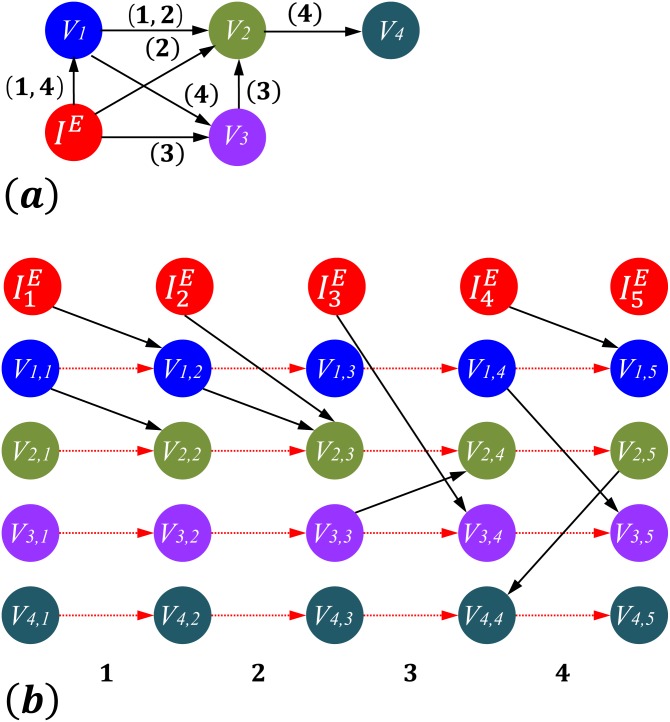
Time-ordered Graph.An example of (a) a temporal network and (b) its corresponding time-ordered graph. The network has 4 nodes {v1, v2, v3, v4} and an external controller IE. The numbers in parentheses in (a) represent time points 1, 2, 3, 4 when the edges are valid. In (b), each node (including the controller) in (a) has 5 duplications (v1 in (a) while v1,1, v1,2, v1,3, v1,4, v1,5 in (b), etc.). The solid edges are either the edges between nodes, or from controller IE to a specific node. The dashed edges are from a node to its self-duplication during the neighbouring time points.